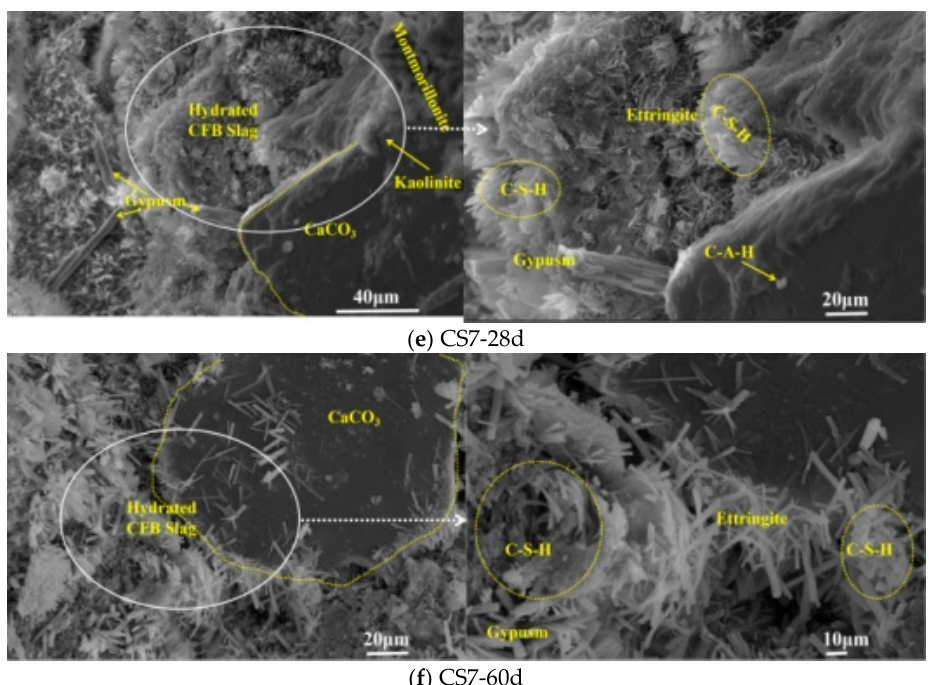
Figure 11. The SEM images of cement-stabilized clay (CS0, cement–CFBS-stabilized clay (CS7) at 7d, 28d, and 60d. ( a ) The SEM image of CS0-7d; ( b ) The SEM image of CS0-28d; ( c ) The SEM image of CS0-60d; ( d ) The SEM images of CS7-7d; ( e ) The SEM images of CS7-28d; ( f ) The SEM images of CS7-60d.